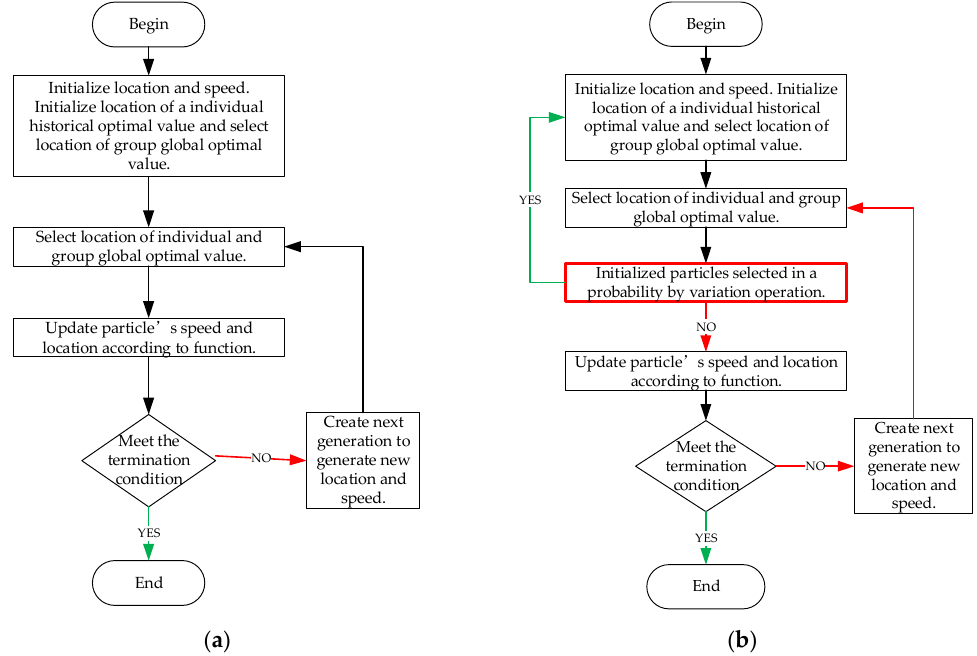
Figure 2. Two target PSO algorithm flowcharts for comparison: ( a ) standard PSO algorithm; and ( b ) optimized PSO algorithm. The red text box shows the mutation operation introduced in this study.